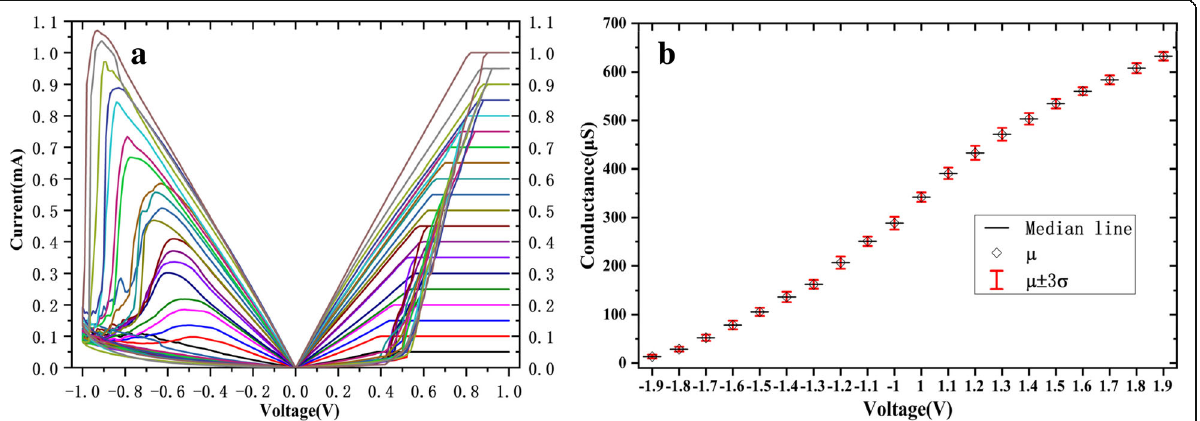
Fig. 5 The multi-value storage of the devices. a Transform resistance states by setting compliance currents. b 20 stable resistance states obtained by setting pulse voltage amplitude The pulse width and interval are both 500 μ s